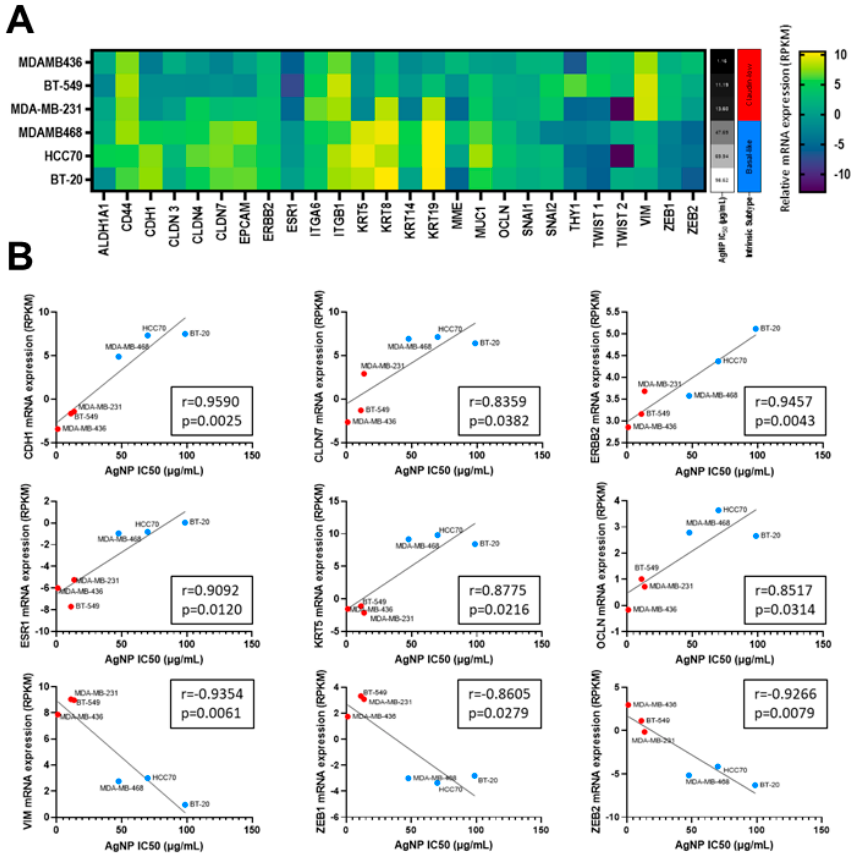
Figure 2. Sensitivity to AgNPs aligns with a CLBC gene signature. ( A ) mRNA expression profiles from the Broad-Novartis Cancer Cell Line Encyclopedia (CCLE) show the expected clustering of CLBC and BLBC cell lines. ( B ) AgNP IC 50 was plotted versus mRNA expression of each gene from ( A ). Pearson’s correlation coefficient (r) was calculated as shown. mRNA expression vs. IC 50 is shown for the subset of genes in ( A ) with expression that significantly correlated ( p < 0.05) with sensitivity to AgNPs.